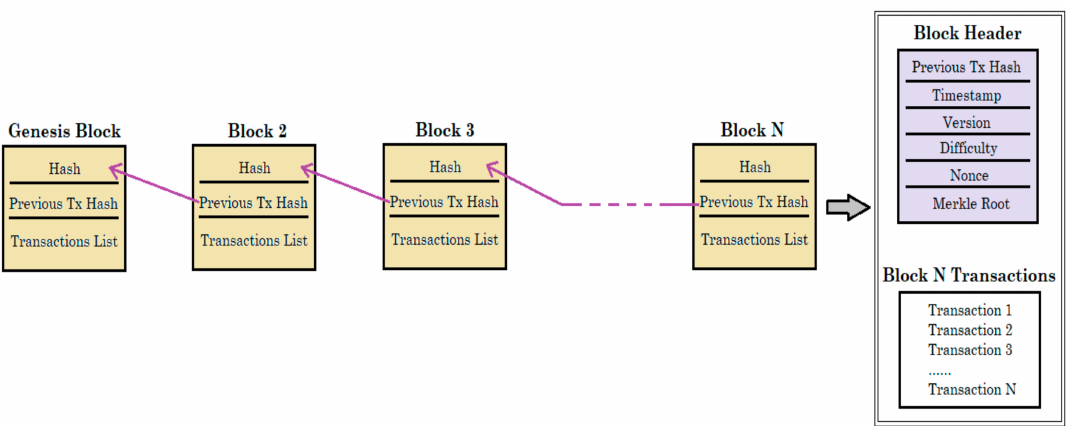
Figure 3. Structure of a